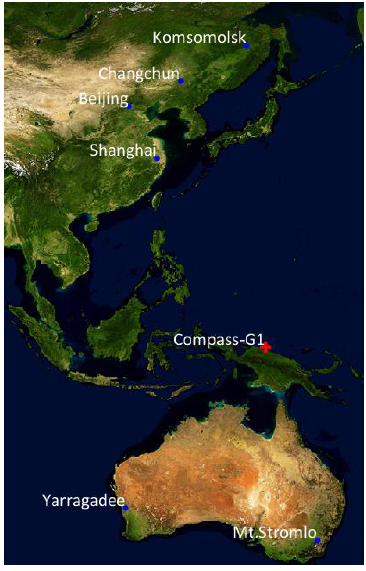
Figure 5. Ground trajectory of Compass-G1 (red cross) and SLR stations (blue dots).